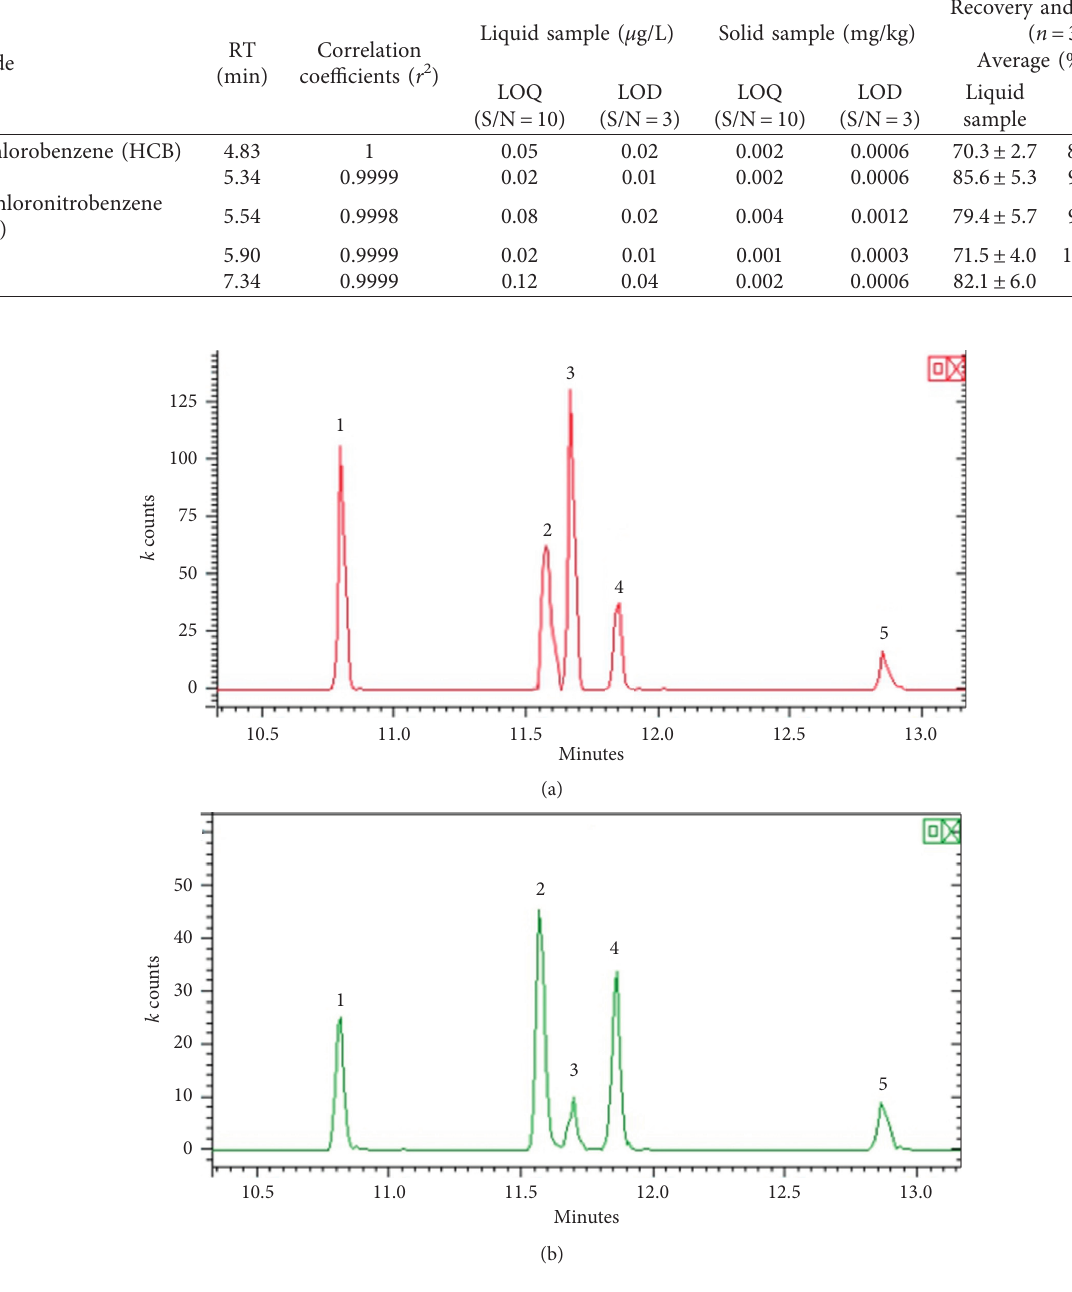
Figure 3: Gas chromatography-tandem mass chromatograms of (a) detected pesticides in the raw ginseng sample and (b) standard pesticide mixtures. Peaks: 1, α -BHC; 2, hexachlorobenzene (HCB); 3, pentachloronitrobenzene (PCNB); 4, c -BHC; 5, δ